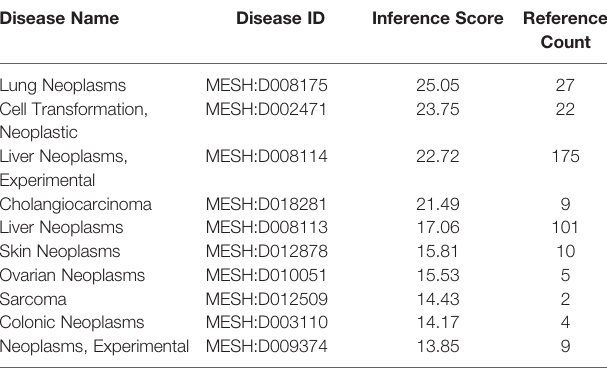
TABLE 1 | Cancer associated with CLEC9A.